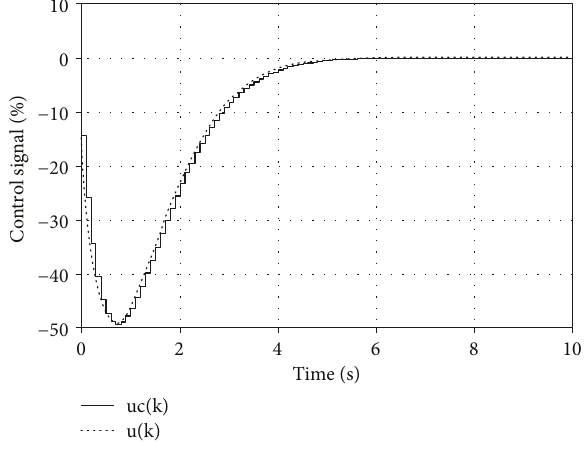
Figure 8: Control output curves.